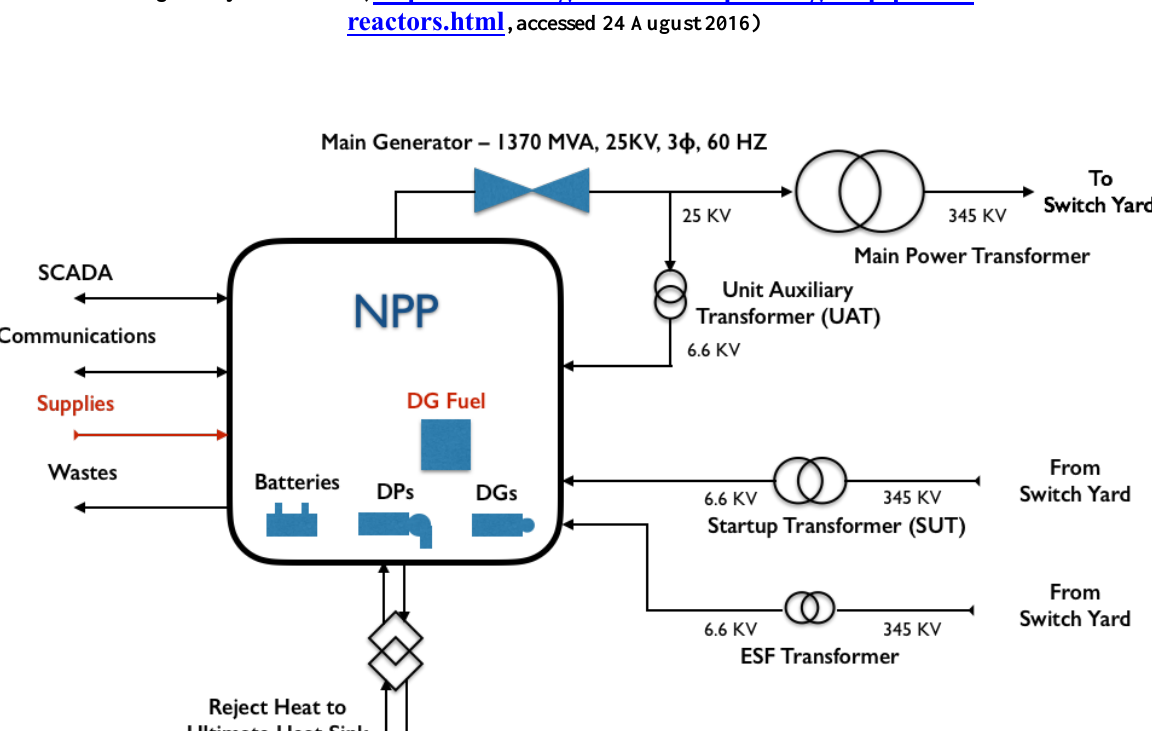
Figure 6. Simplified representation of NPP interfaces with the Grid and the world outside the plant boundary (Source: S. R. Greene, Advanced Technology Insights,